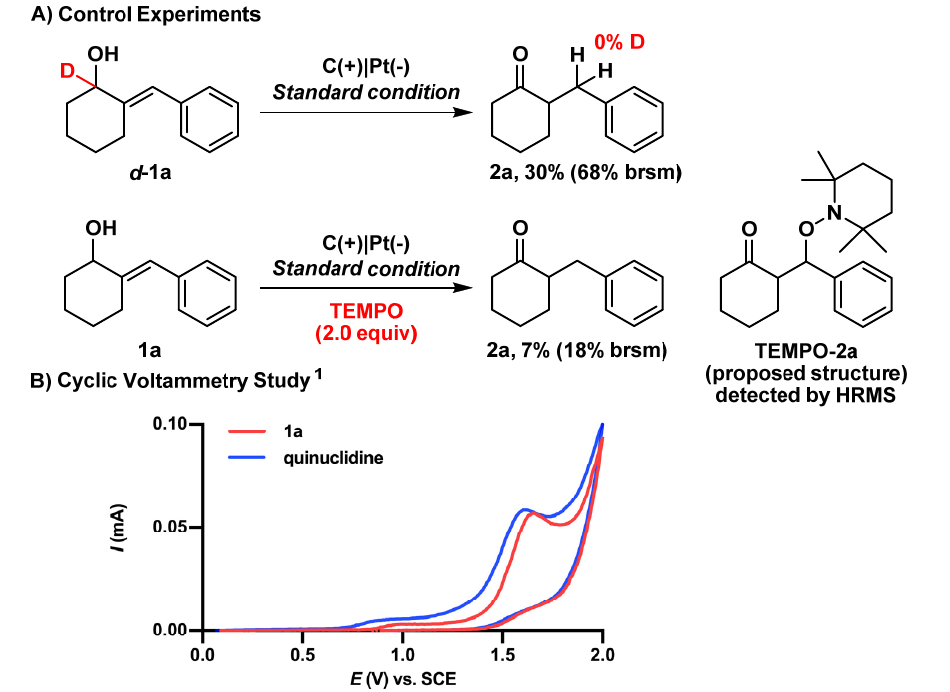
Figure 4. Mechanism studies. ( A ) Deuterium label experiment and radical trapping experiment. ( B ) Cyclic voltammetry study. 1 Cyclic voltammograms of substrate 1a and quinuclidine in dry and deoxygenated MeCN/toluene (5:1) containing n Bu 4 NH 2 PO 4 (1.0 equiv.) and a potential sweep rate of 100 mV/s (vs. SCE). brsm = based on recovered starting material.